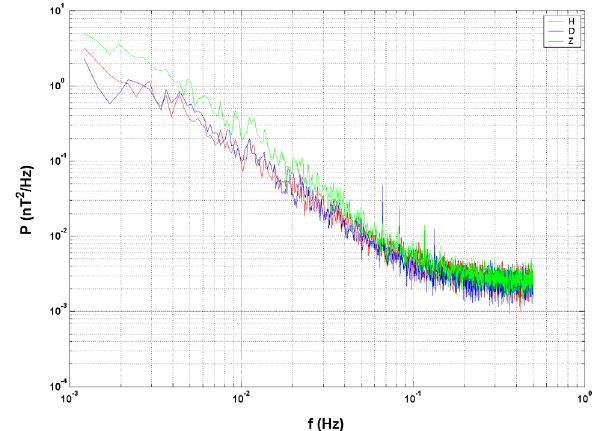
Figure 6. Power spectra of the geomagnetic field components in logarithmic